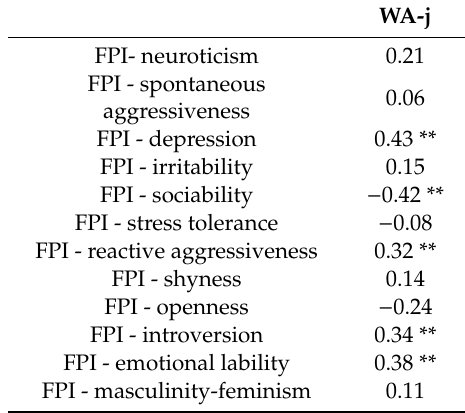
Table 4. Pearson correlation values of Questionnaire of work alienation–concrete job and FPI